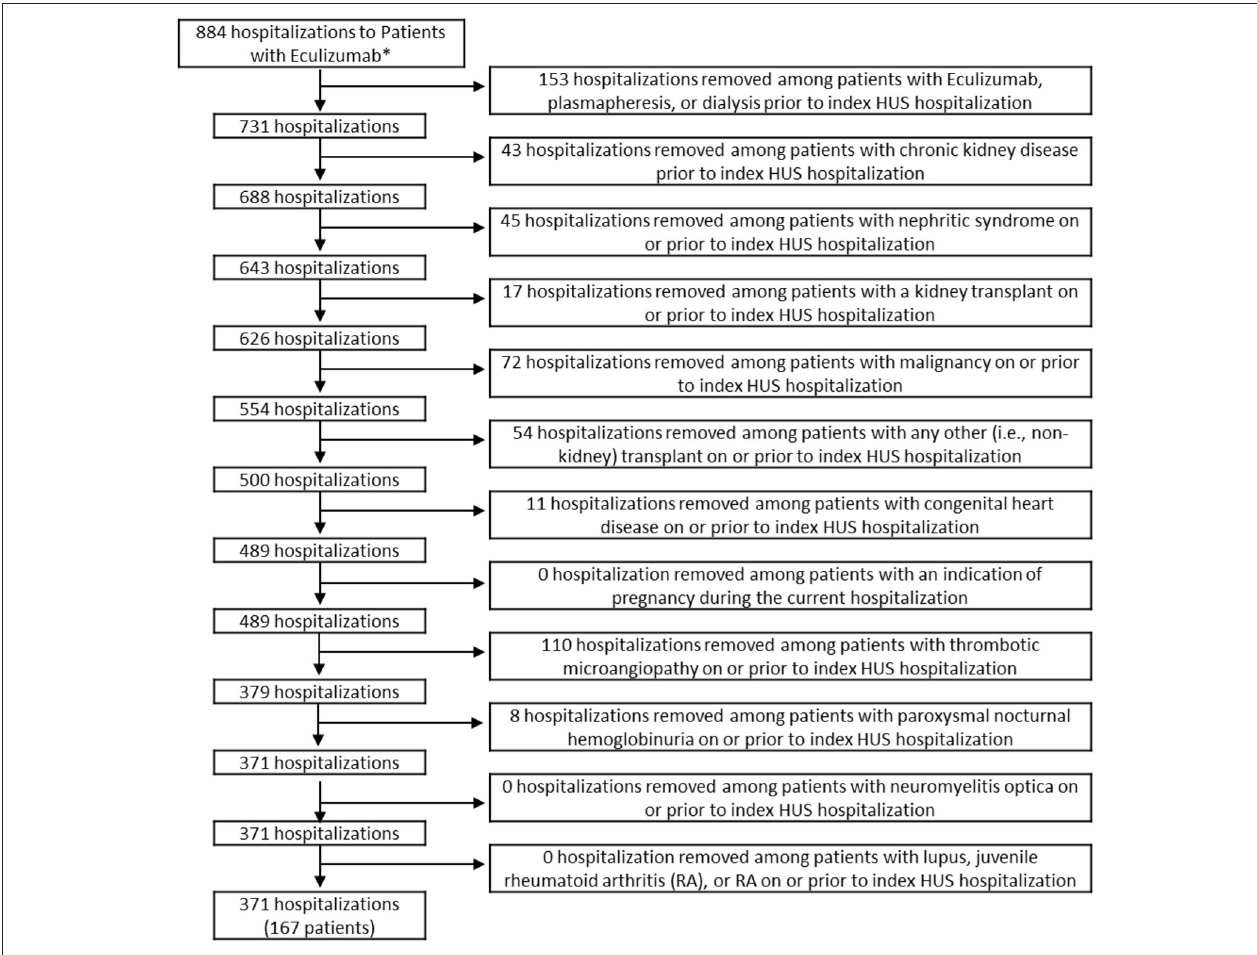
FIGURE 2 | Inclusion and exclusion criteria of patients who received eculizumab. *Hospitalizations were limited to those among patients aged ≤ 18 who were discharged after 9/23/2011. Patients in the eculizumab group had eculizumab during or after the index HUS visit. HUS, hemolytic uremic